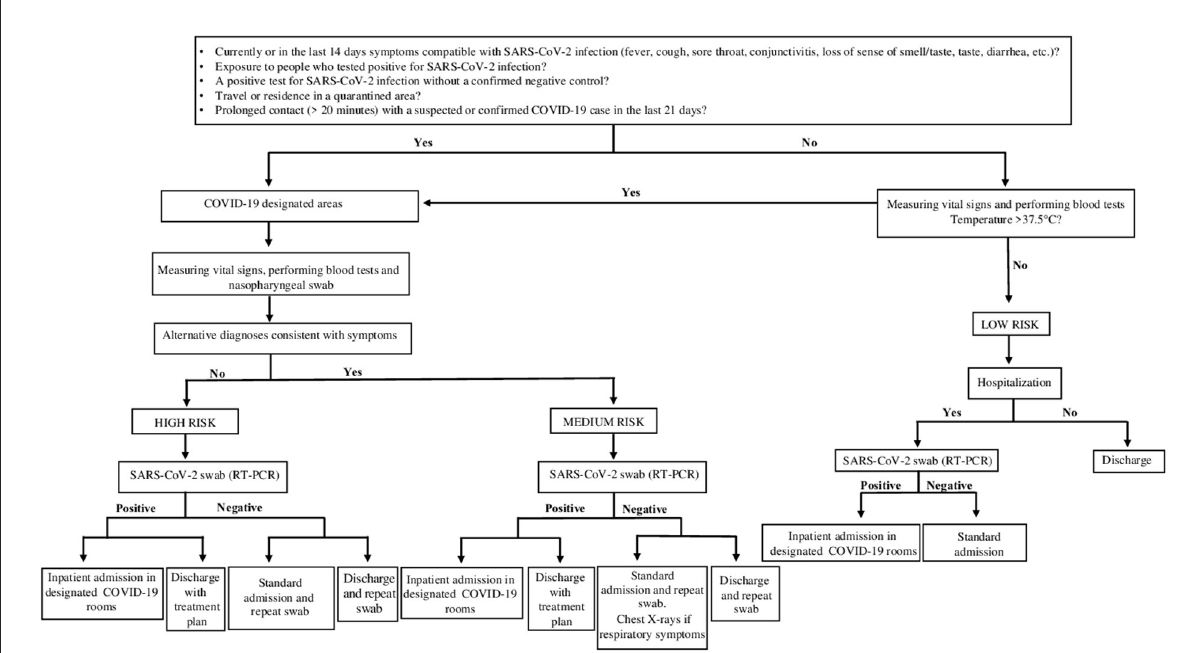
FIGURE1 Testing algorithm for diagnosis SARS-CoV-2 infection in patients who presented to the ED from 1 March 2020 – 31 October 2020 (Period A). The standardized screening strategy was molecular swab only (RT-PCR). Waiting for the results of the molecular swab (RT-PCR), patients according to their clinical and epidemiological characteristics were divided into corresponding risk classes (High Risk; Medium Risk; Low Risk).